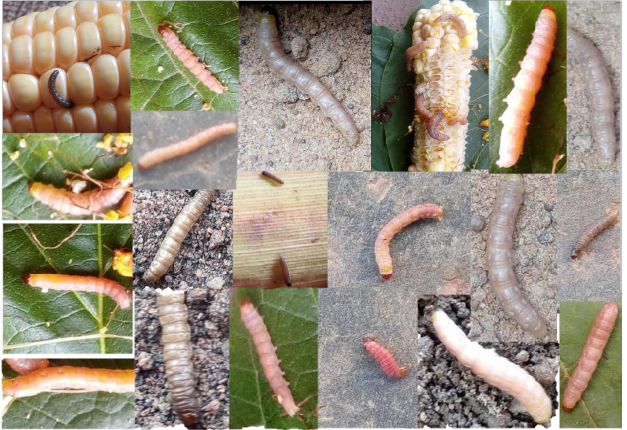
Figure 7. Samples of insects from our dataset. https://github.com/obasekore/Spodopera_DL_ dataset, accessed on 5 March